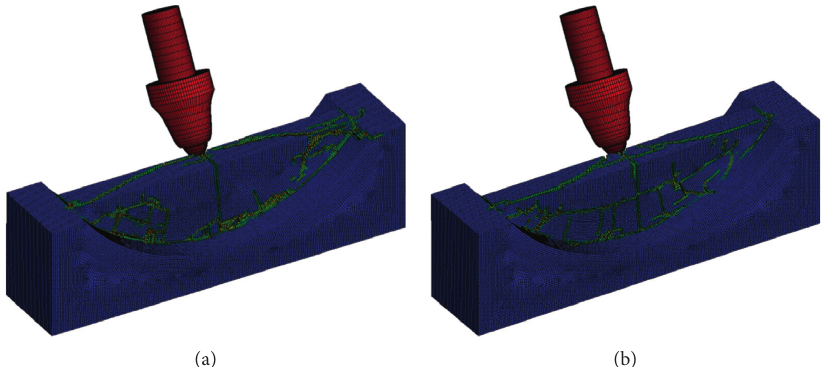
Figure 12: The numerical simulation results of conical pick with various cutting speed cutting arc rock